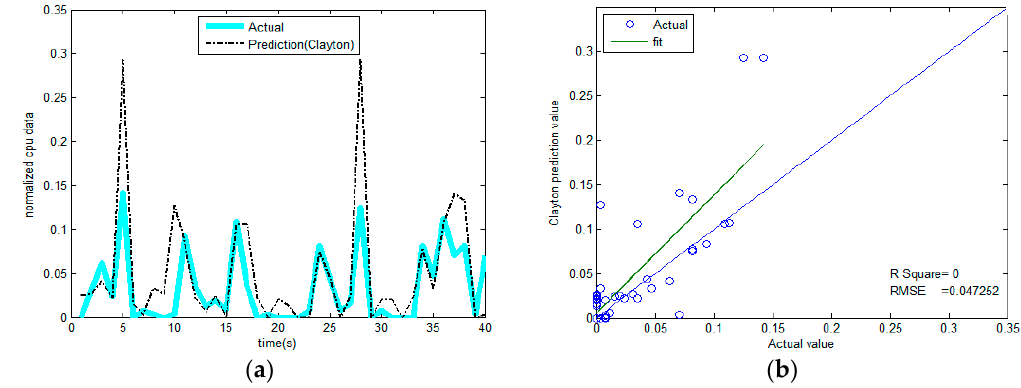
Figure 13. Prediction of CPU through flow. ( a ) Clayton-copula for CPU series; ( b ) Comparison correlation coefficient of CPU.